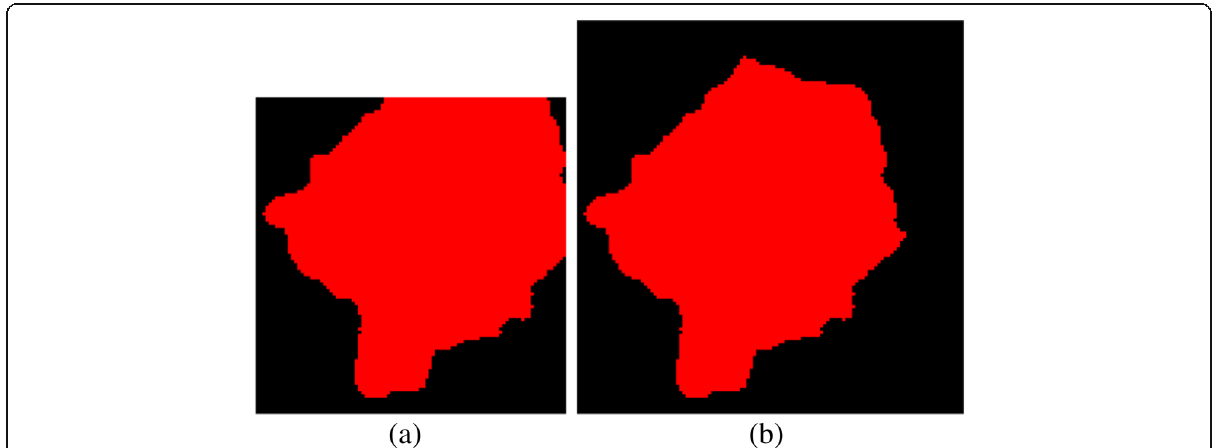
Fig. 7 An example of the binary correlation map and extension. The red color indicates “ true ” in the correlation map. a The red region is the largest region after performing the connected-component operation. This region touched the top border and right border. b The result after extending the direction of the top and right borders